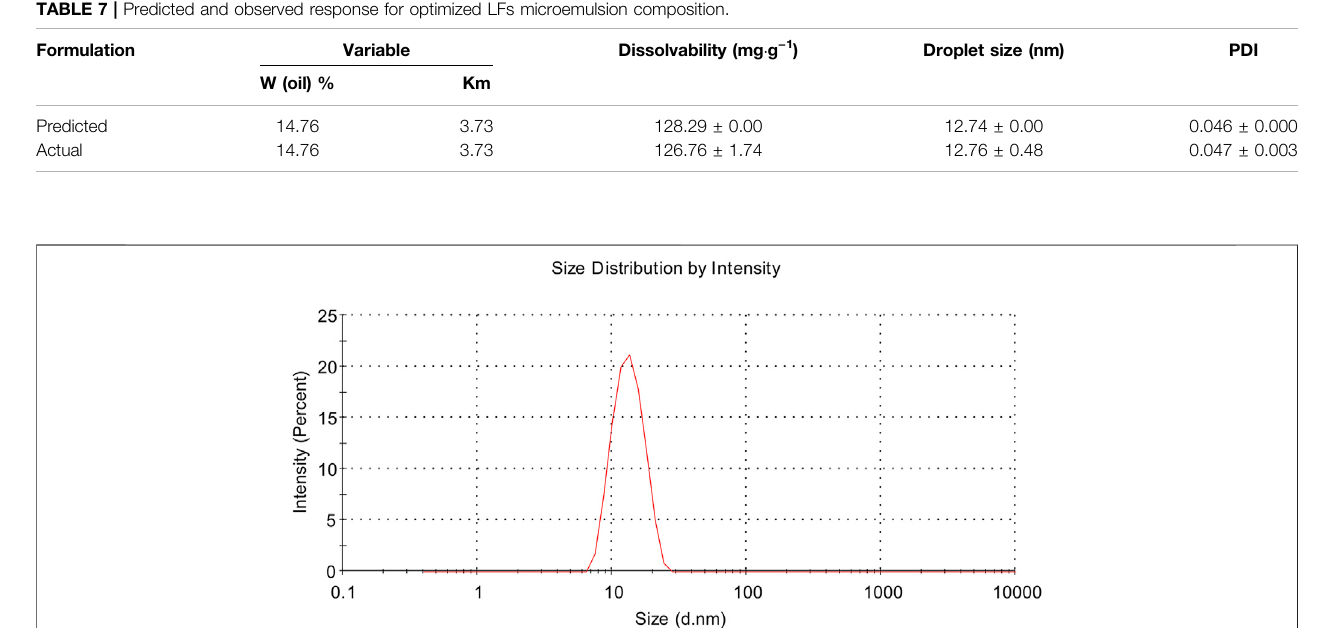
FIGURE 5 | Representative droplet size distribution graph of LFs